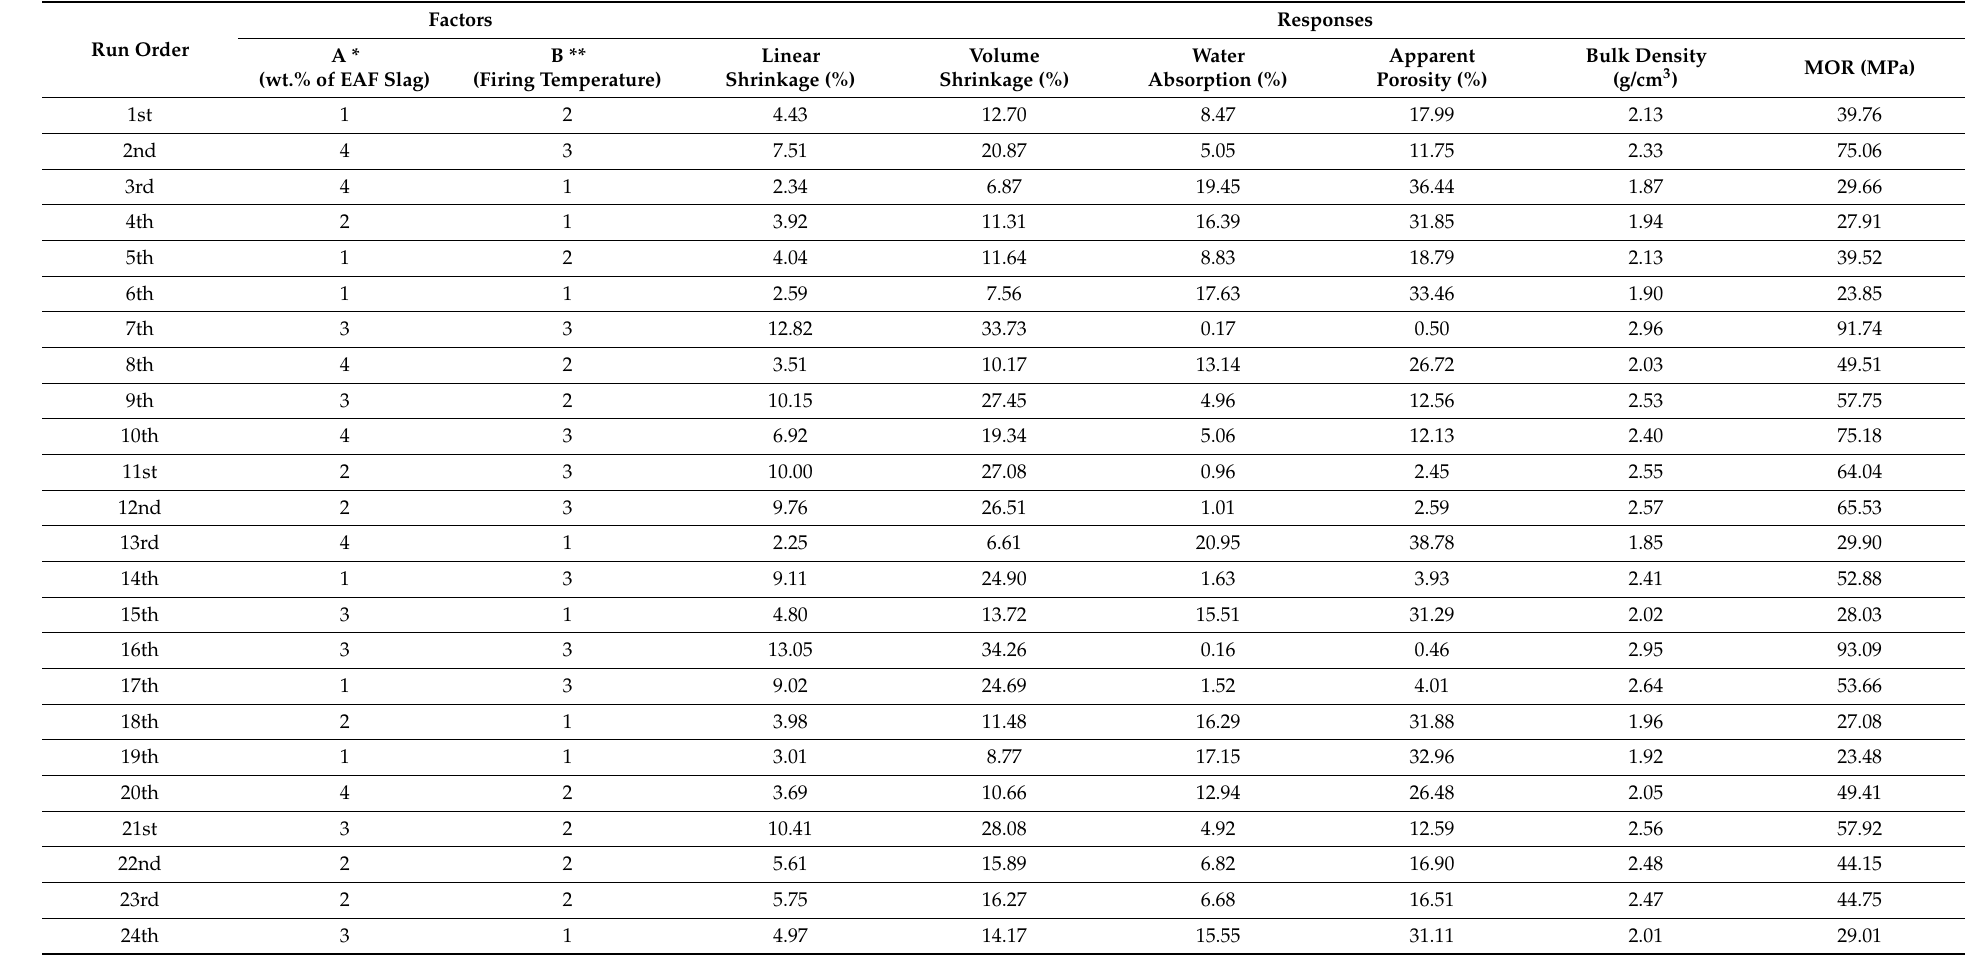
Table 3. Experimental design matrix for general full factorial design (including values for all